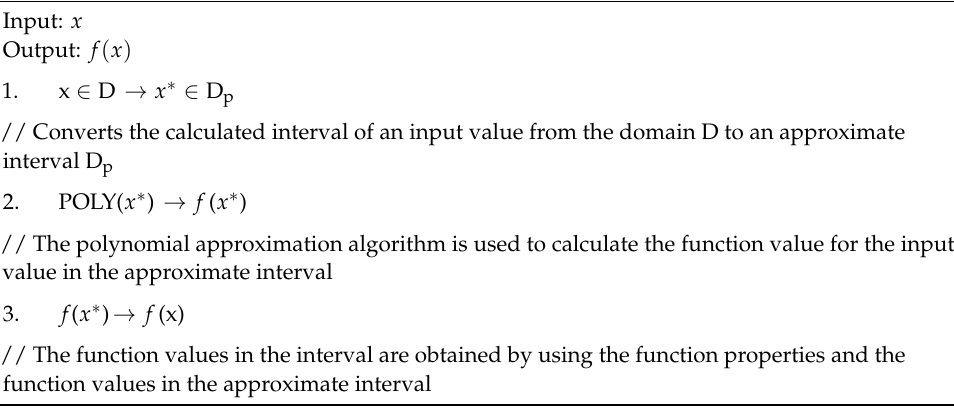
Algorithm 1. Interval transformation-polynomial approximation